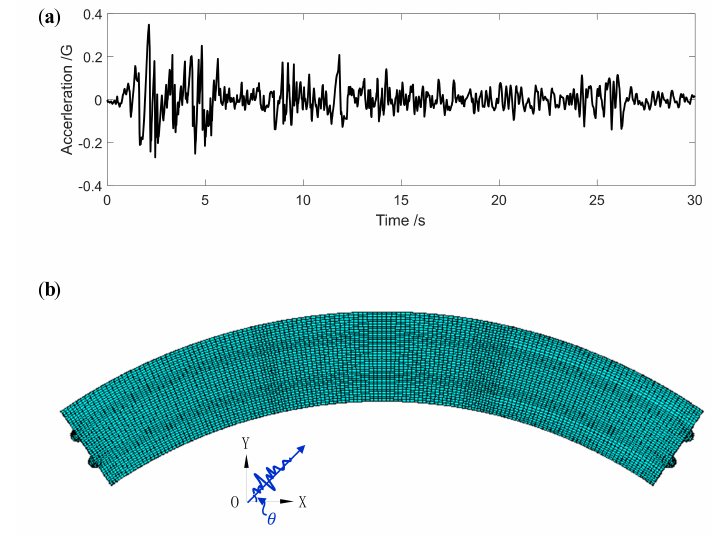
Figure 4. El Centro earthquake: ( a ) acceleration wave; ( b ) input angle.